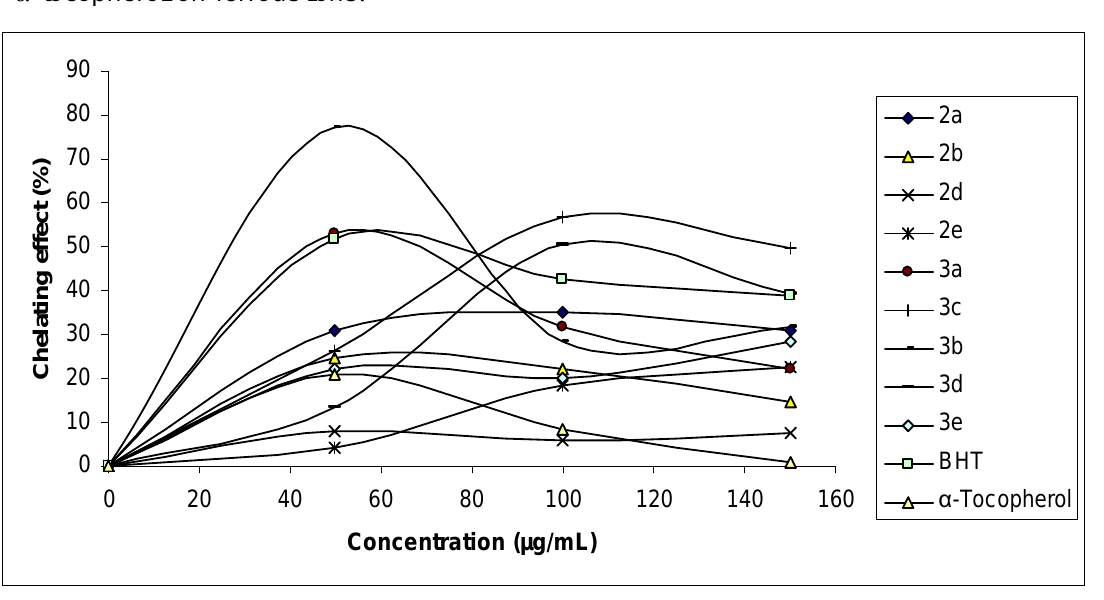
Figure 4. Metal chelating effect of different amount of the compounds 2 and 3 , BHT and α -tocopherol on ferrous